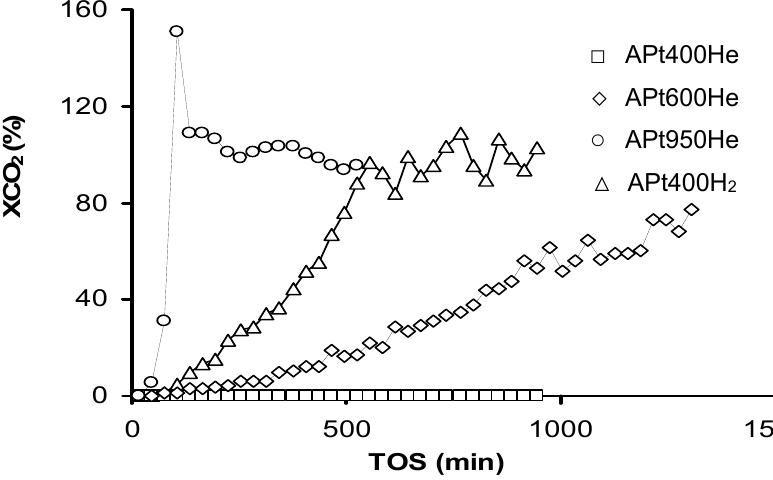
Figure 12. Conversion of o -xylene to CO 2 obtained at 190 °C in function of time on stream (TOS) ([ o- xylene] = 0.10 vol.%, Q = 3.6 L h − 1 , 0.10 g catalyst ). Figures reprinted with permission from [67]. Copyright 2005,